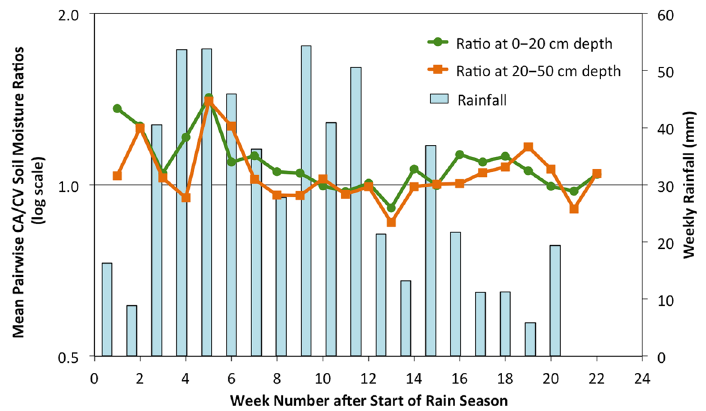
Figure 5. Mean weekly ratios of soil moisture in riplines/basins relative to moisture in paired ploughed/ridged fields (CA/CV) at two soil depths for the 2014/15 cropping season plus mean weekly rainfall in the Mumbwa, Monze, and Chipata areas.